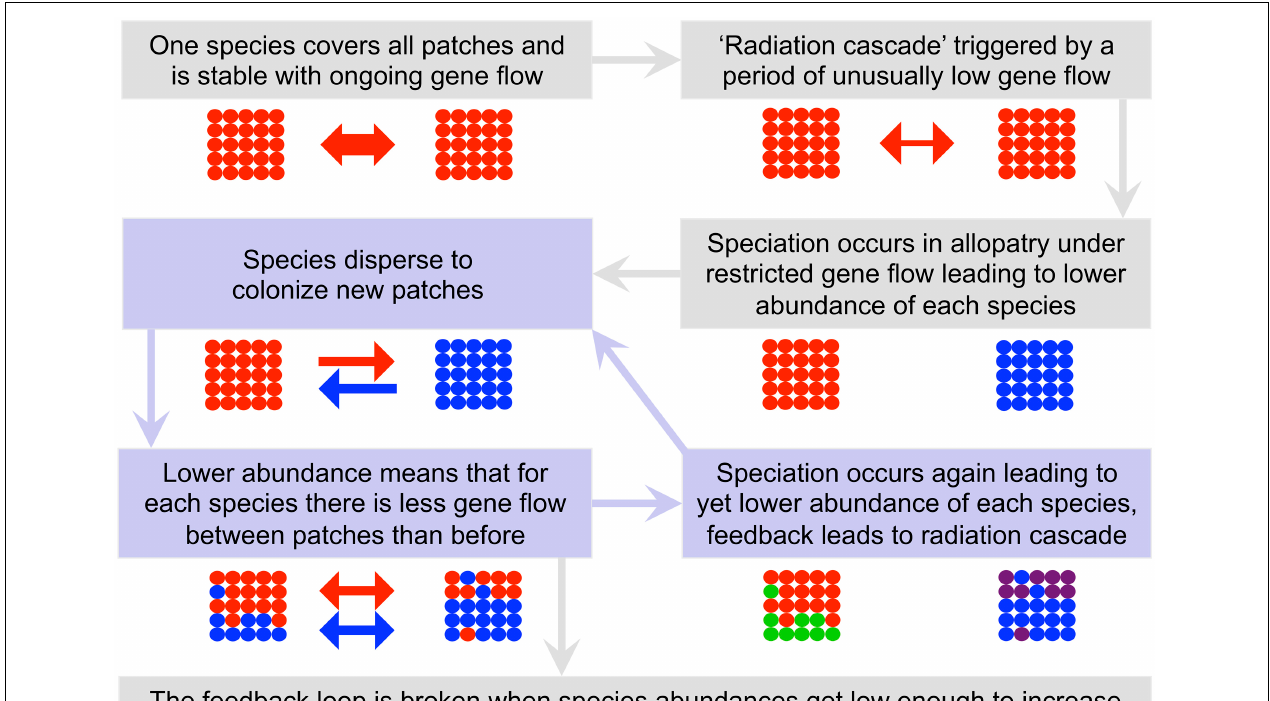
FIGURE 10 | A cartoon explaining the radiation cascade mechanism. In this example the community consists of two local habitat patches each with 25 individuals. Colored circles represent individual organisms with color representing species. The arrow(s) between the two local habitat patches indicate the strength and direction of dispersal (and thus gene flow) for each species individually. The gene flow arrows are colored to match the color of the species to which they refer. Shaded boxes and lightly shaded arrows between them indicate the stages of a radiation cascade, with the focal feedback loop that leads to the cascade being shown in a light